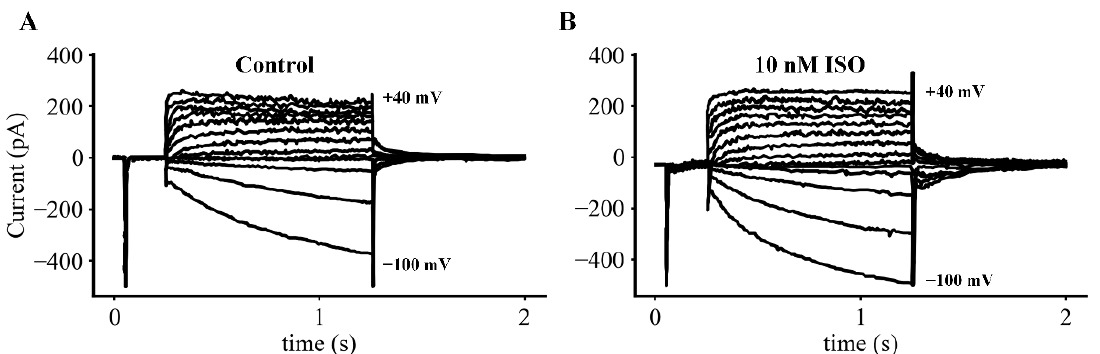
Figure 2. Families of whole cell or macroscopic transmembrane currents in an SAN primary pace- maker myocyte at 35 °C. ( A ): Transmembrane current recording in control conditions. ( B ): Trans- membrane current recording in 10 nM ISO. The transmembrane current records in both ( A , B ) were obtained in normal Tyrodes in response to 1 s rectangular voltage clamp steps, that displaced the membrane potential from − 100 to +40 mV from a holding potential (HP) of − 60 mV. These were applied every 8 s in 10 mV increments. A 50 ms pre-pulse to − 40 mV was included in all cases to inactivate the transient inward Na + and activate Ca 2+ currents. This protocol resulted in most of the time- and voltage-dependent outward currents being due to a delayed rectifier K + conductance, I Kr ; and the slow development of inward currents being generated mainly by I f . The superimposed family of currents in ( B ) provide a qualitative indication of the changes in these families of currents recorded 5 min after 10 nM ISO was added to the superfusate. All recordings were made in the amphotericin-mediated whole cell patch clamp configuration (see Methods).